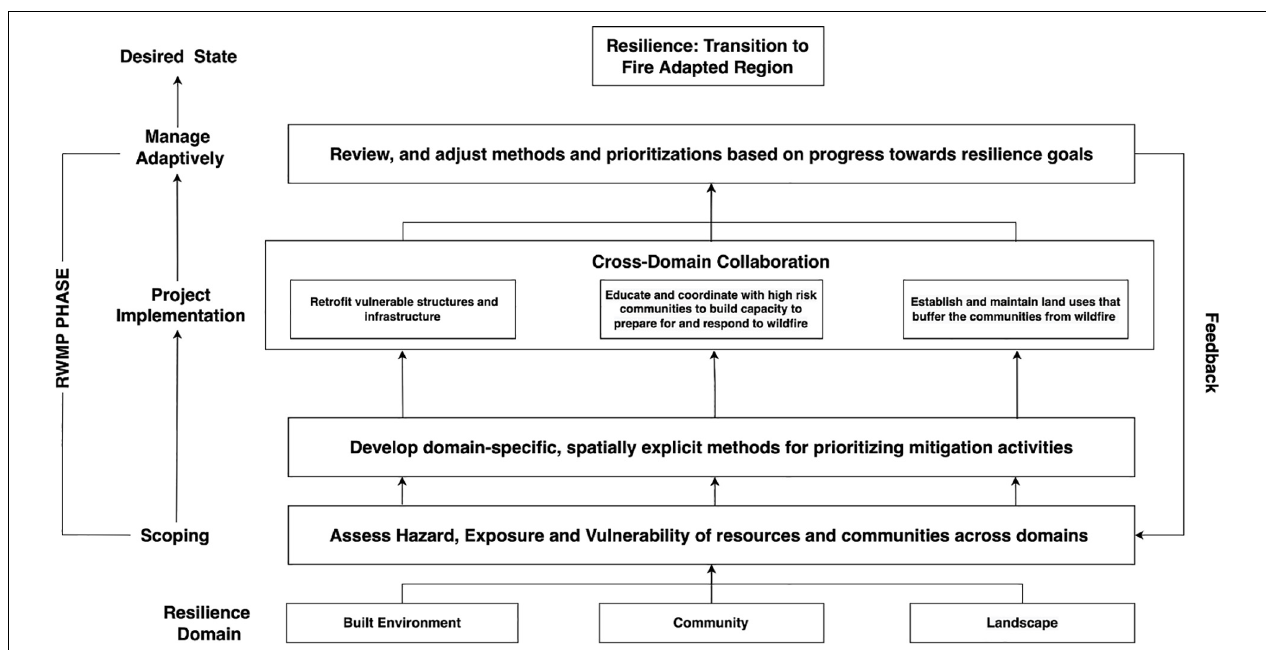
FIGURE 7 | Regional Wildfire Mitigation Program (RWMP) structure, recognizing three domains and three phases of activity. As an ongoing program, the RWMP also needs to adapt with changing conditions and thus involves an iterative feedback loop to continuously refine risk mitigation priorities.